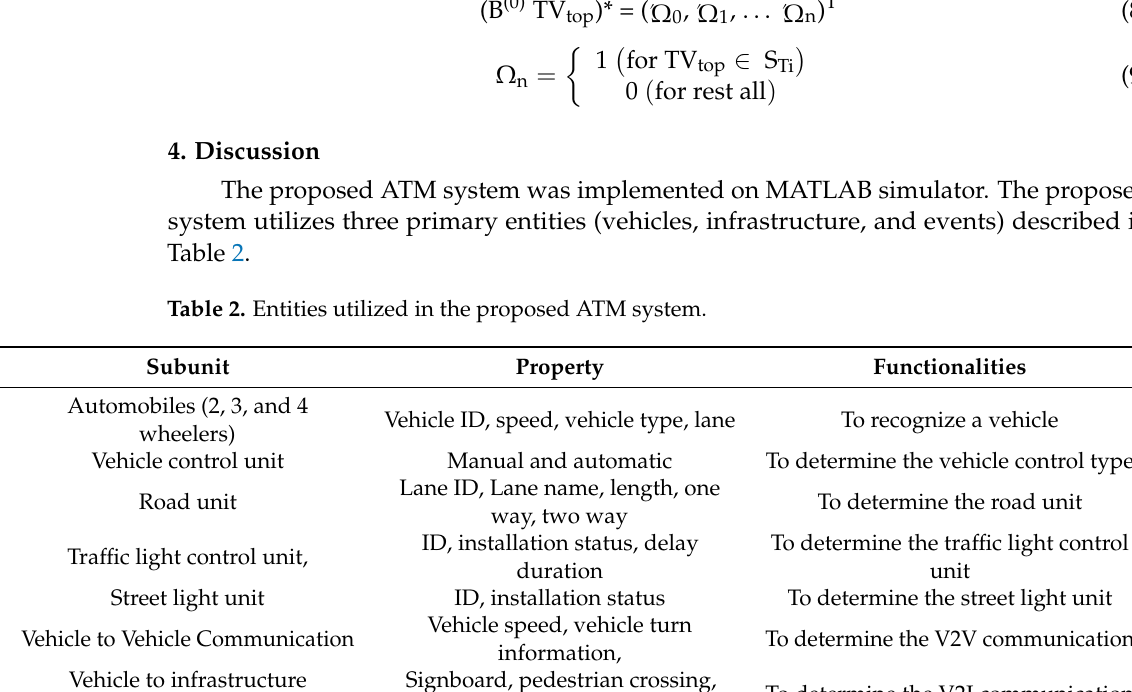
13 of 28 Figure 6. Traffic flow space vs. time (incoming and outgoing vehicles). Mathematical Model Formulation for Proposed ATM Let the vehicle congestion deterministic model CDM in a platoon of vehicles (V i ) on the road (R i ) be (I = 1…n). The Markov speed (M speed ) property of any vehicle in a platoon. State space can be defined as {S T0 …S Tn ). A matrix (M) for state space can be defined as follows: